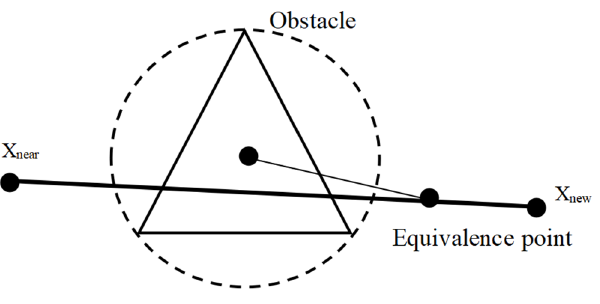
Figure 4. Collision detection schematic diagram of RRT algorithm.